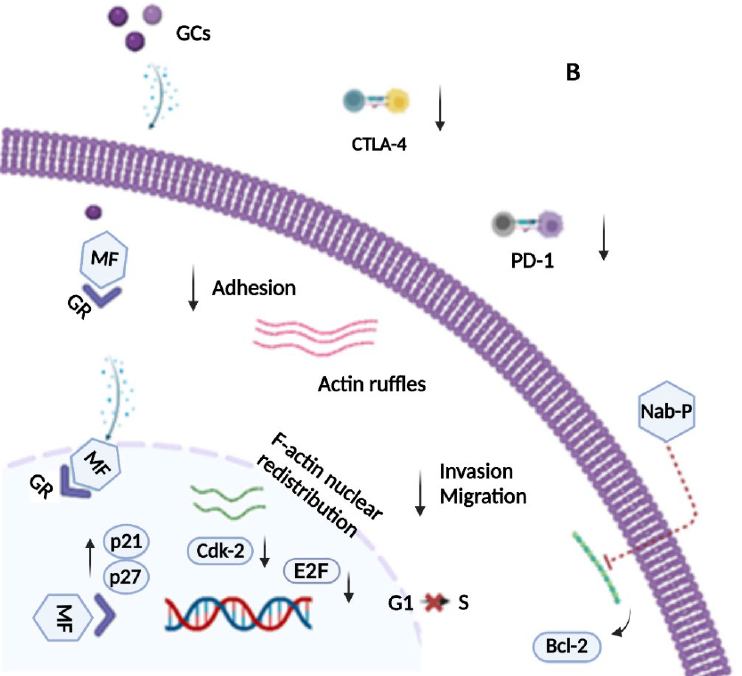
Figure 3. ( A ) Relacorilant is a selective GR modulator that restores the programmed cell death cascade that is suppressed by cortisol. Relacorilant acts by targeting MKP-1 and SGK-1 gene transcription. SGK1 has been hypothesized to phosphorylate FKHRL1, thereby leading to its cytoplasm translocation and preventing BID and BIM gene expression. The MKP1/DUSP1 gene encodes for a MAPK phosphate, which preferentially inhibits p38MAPK and the c-Jun N-terminal kinase (JNK) transduction pathways, thereby resulting in decreased anti-apoptotic protein BCL-2 levels. ( B ) Mifepristone is a synthetic steroid that acts as a GR antagonist. It reduces OC cell growth by promoting the nuclear localization of p21 and p27 and by decreasing cdk2 activity, thus resulting in OC cell G1 phase arrest. In addition, in preclinical models, MF promoted cytoskeletal rearrangements such as membrane ruffling, lacking adhesion capacity and nuclear distribution of fibrillar actin, reducing OC cell invasive capacity. Moreover, MF administration resulted in decreased PD-1 and CTLA-4 expression, which suggests that GR plays a role in tumor immune evasion. Nab-Paclitaxel is a cell cycle specific agent that prevents microtubule depolymerization and inhibits BCL-2 protein-enhancing cell apoptosis. Created with BioRender.com.